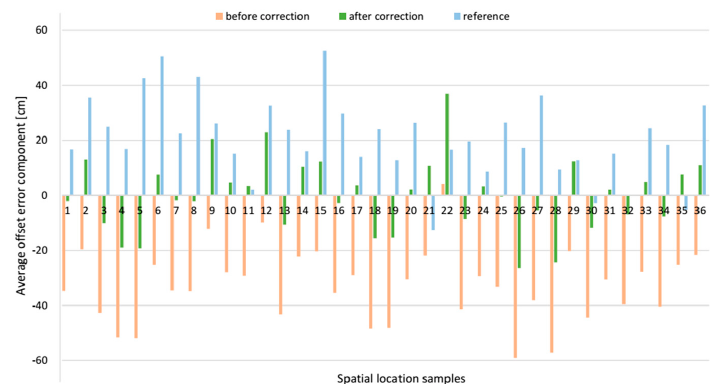
Figure 19. Comparative bar plots of the average offset errors of the z components for AB pair. Sensors 2017 , 17 , 227